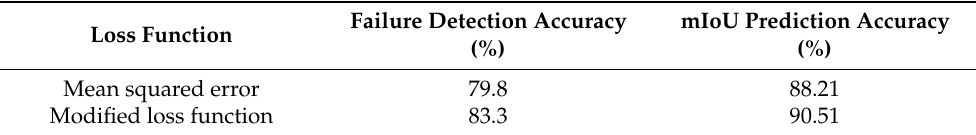
Table 15. Failure detection and mIoU prediction accuracy for the different loss function for the Hyundai Motor Group (HMG) dataset.